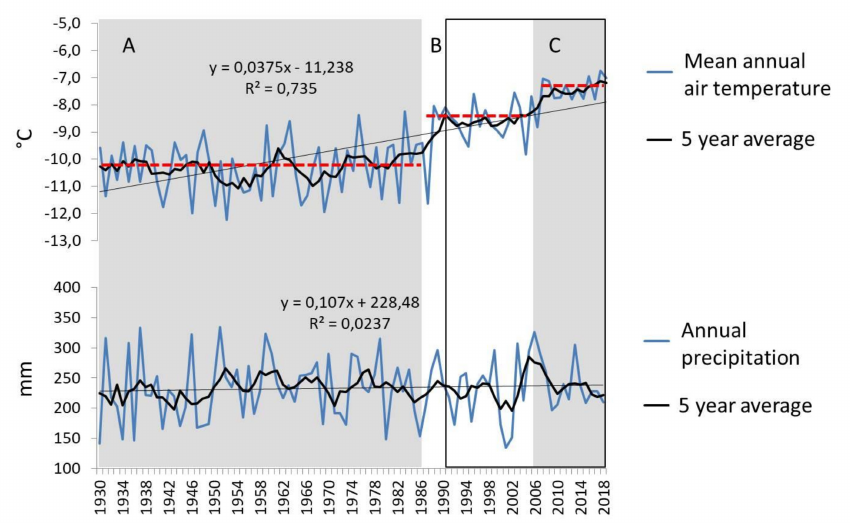
Figure 2. Climatic data for the 1930–2018 period (weather station Yakutsk). Red dotted line: periods of Table 1. In general, there is an increase in temperature for all months. The highest positive increase is noted in December and January during winter. In springtime in March, April and May and autumn season in October (Table 1). Precipitations showed a decrease in − 4.7 mm during summer of C